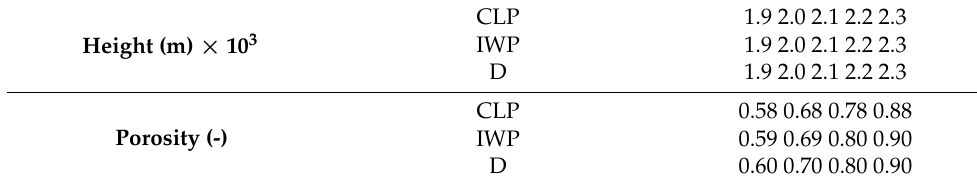
Table 5. Different heights and porosity of feed channels based-on